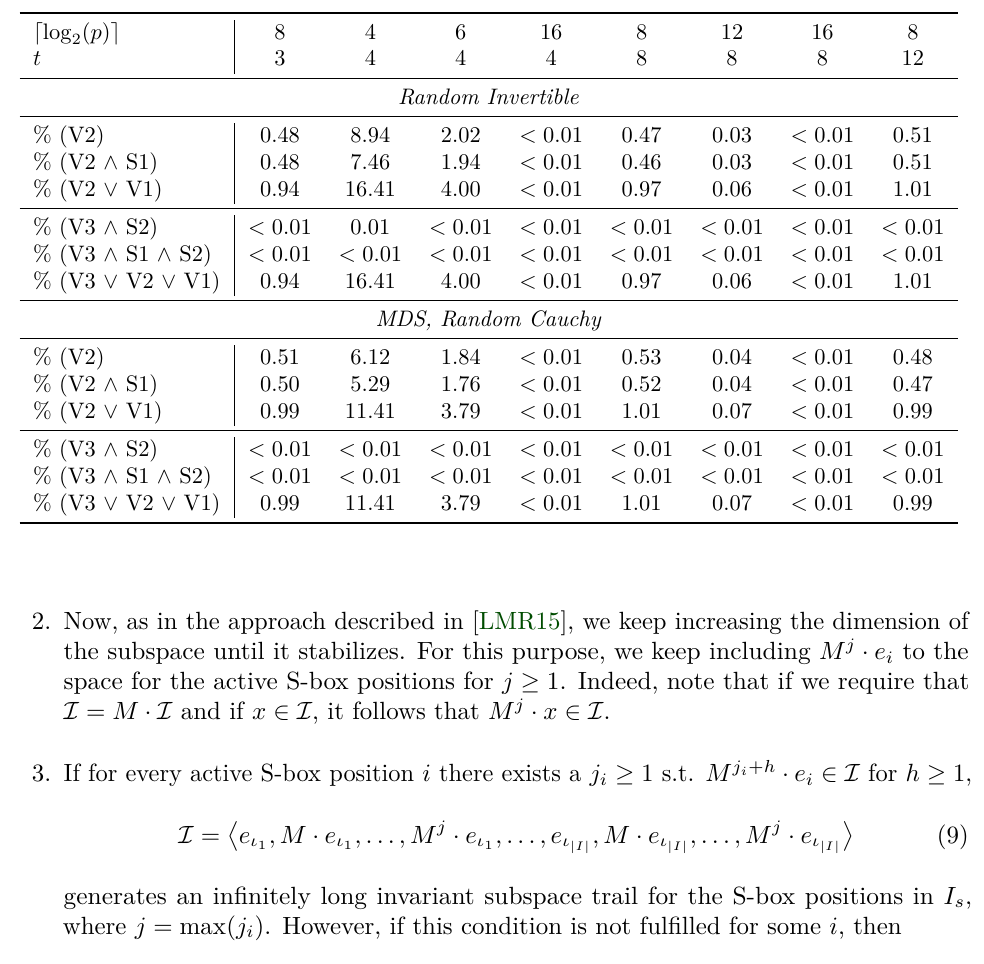
Table 3: Percentage of vulnerable matrices using Algorithm 1, Algorithm 2, Algorithm 3 over prime fields F t . We denote by “S x ” and “V x ” the security and vulnerability w.r.t. p Algorithm x , respectively (e.g., S1 denotes security w.r.t. Algorithm 1, while V2